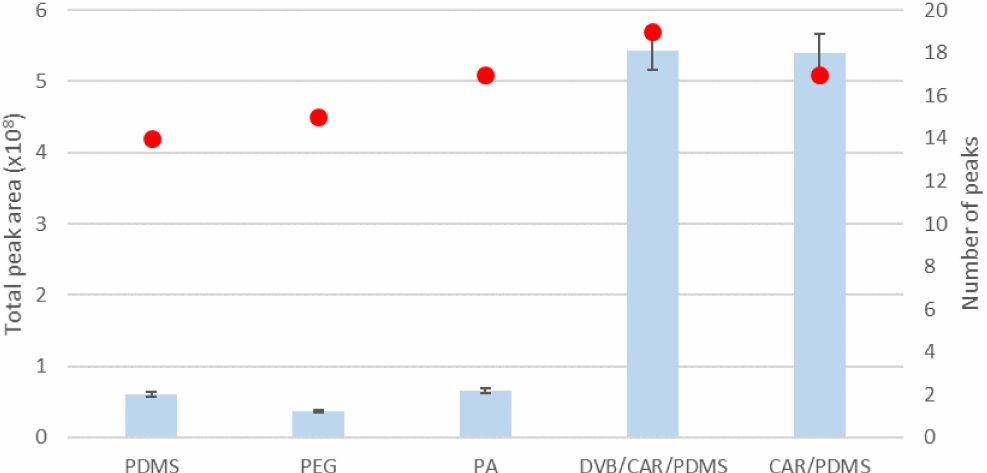
Figure 1. The results of SPME / GC–MS analysis of di ff erent fiber coatings (SPME extraction at 50 ◦ C for 15 min). PDMS—100 µ m Polydimethylsiloxane, PEG—60 µ m Carbowax / Polyethylene Glycol, PA—85 µ